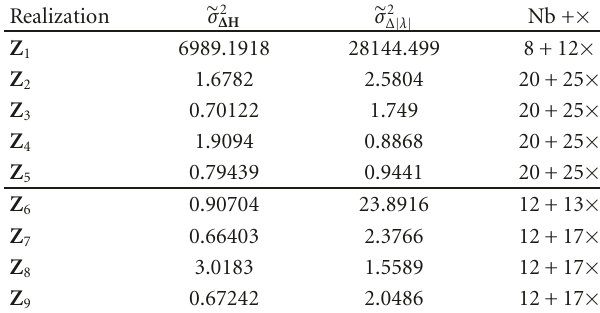
, (cid:11) σ 2 Δ | λ | and number of operations for the di ff erent H